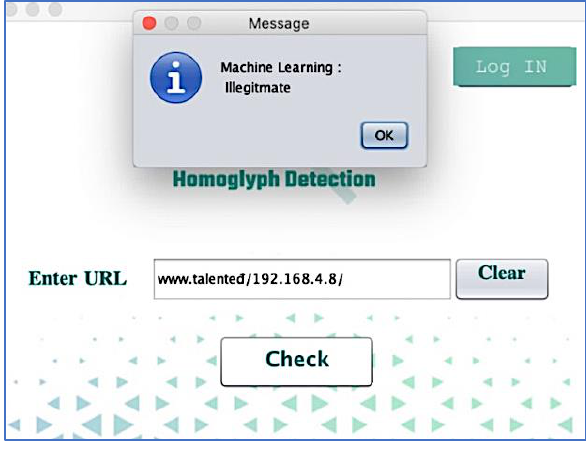
Figure 9. Phishing site .